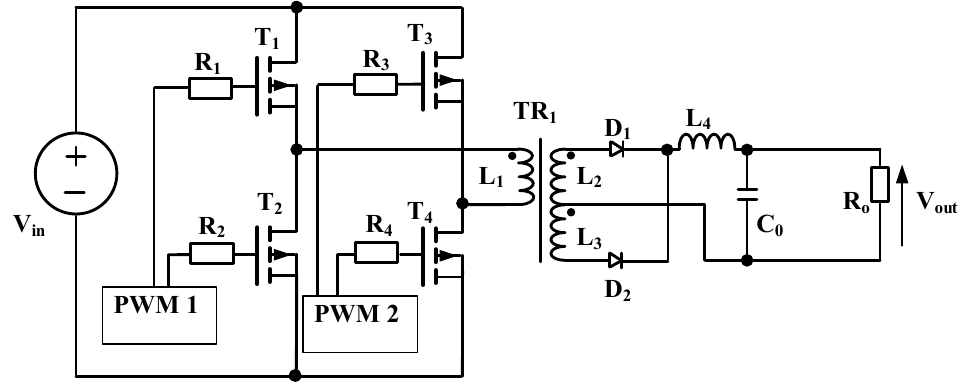
Figure 1. Diagram of the investigated full-bridge converter .